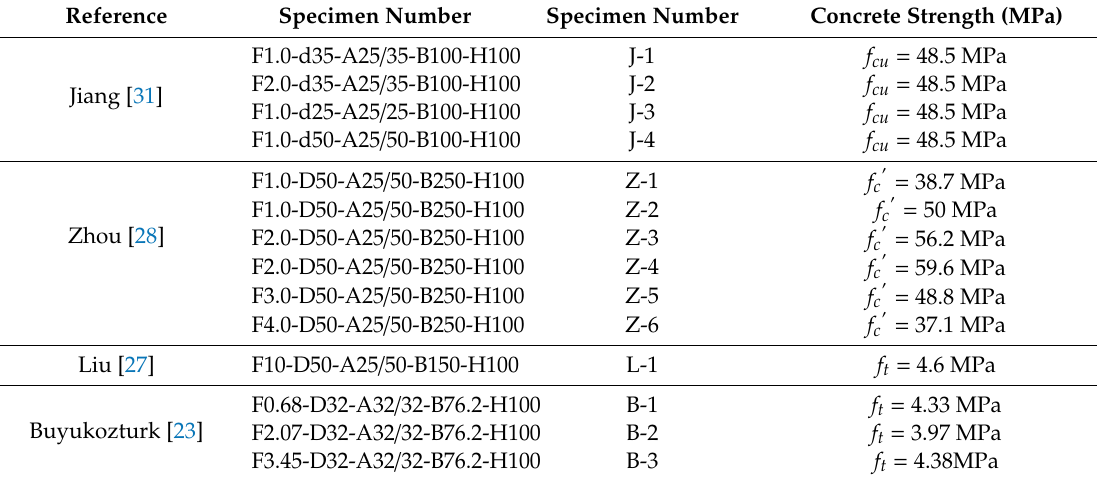
Table 5. Summary of test specimens in references.